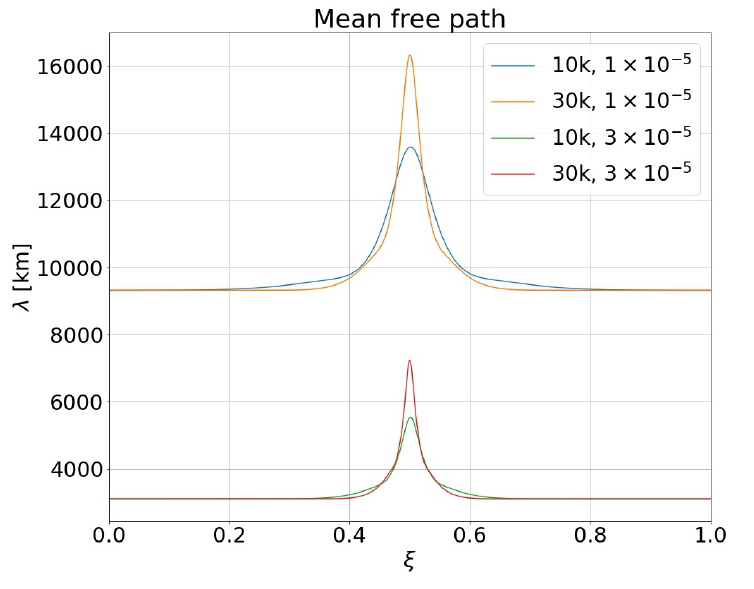
Figure 8. The calculated energetic particle mean free paths for simulations of coronal loops with the sizes L = 10,000 km and L = 30,000 km. The 30,000 km loop, α = 3 × 10 − 5 simulation has a spatial cell size ∆ x = 5 km and the rest have a spatial cell size ∆ x = 20 km. The loop lengths in kilometers and normalization values for the curves are displayed in the legend in the mentioned order.